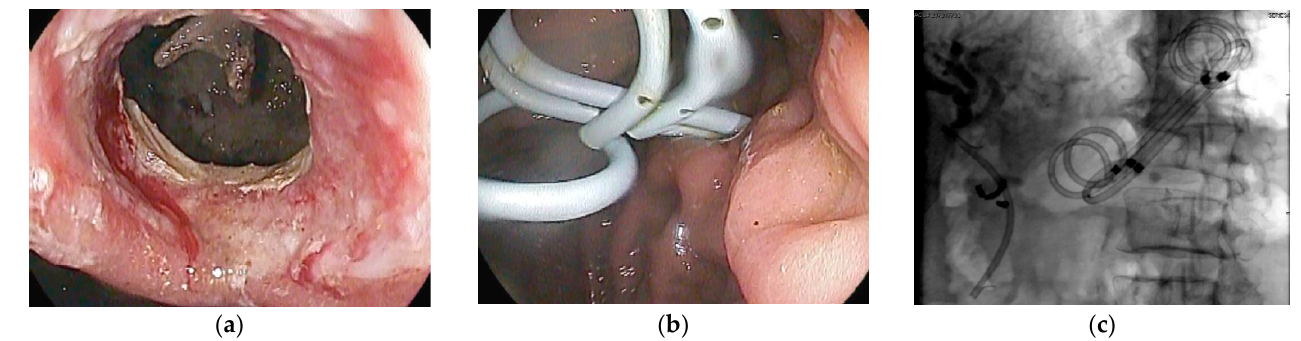
Figure 6. Disconnected duct syndrome with LAMS removal and placement of double pigtail stents. ( a ) Endoscopic imaging showing LAMS removal with a residual portal into cyst cavity in a patient with known disconnected duct syndrome; ( b ) transmural plastic double-pigtail stents placed inside the cyst cavity; ( c ) fluoroscopic image showing double-pigtail stents to prevent recurrence of pancreatic fluid collection.